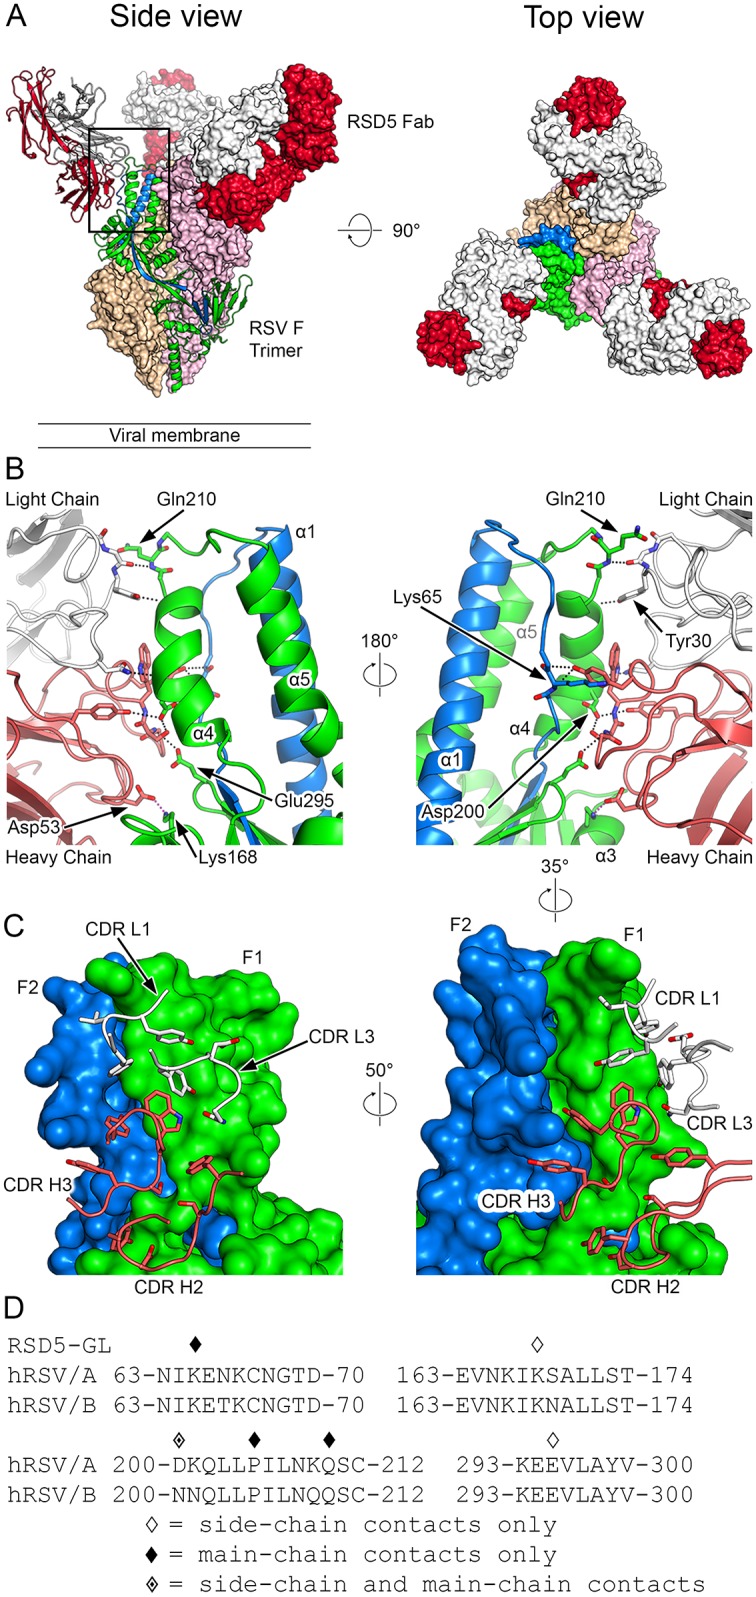
Structure of RSD5-GL in complex with prefusion RSV F.(A) Crystal structure overview shows three RSD5-GL Fabs bound to the prefusion RSV F trimer, viewed looking along or toward the viral membrane. One RSV F protomer and the contacted RSD5-GL Fab are shown in ribbon representation (left panel), whereas the other protomers and Fabs are shown as molecular surfaces. The RSD5-GL heavy chain is colored red and the light chain is white. One RSV F protomer is colored green for F1 and blue for F2, whereas the other two RSV F protomers are tan and pink. (B) Close-up of the side views of the interactions between one RSD5-GL Fab and one RSV F protomer in ribbon-and-stick representation, rotated 180° from each other and colored as in (A). For stick models, oxygen atoms are colored red, nitrogen blue, and sulfur yellow. (C) Ribbon-and-stick model of the RSD5-GL CDR loops contacting one protomer of RSV F, which is shown as a molecular surface. Colored as in (B) and rotated as indicated. (D) The amino acid sequence of residues near RSV F site Ø and site V are shown for both strain A2 and strain B9320. Diamond symbols above each residue indicate a contact between RSD5-GL and prefusion RSV F strain A2 based upon PDBePISA analysis of the crystal structure.